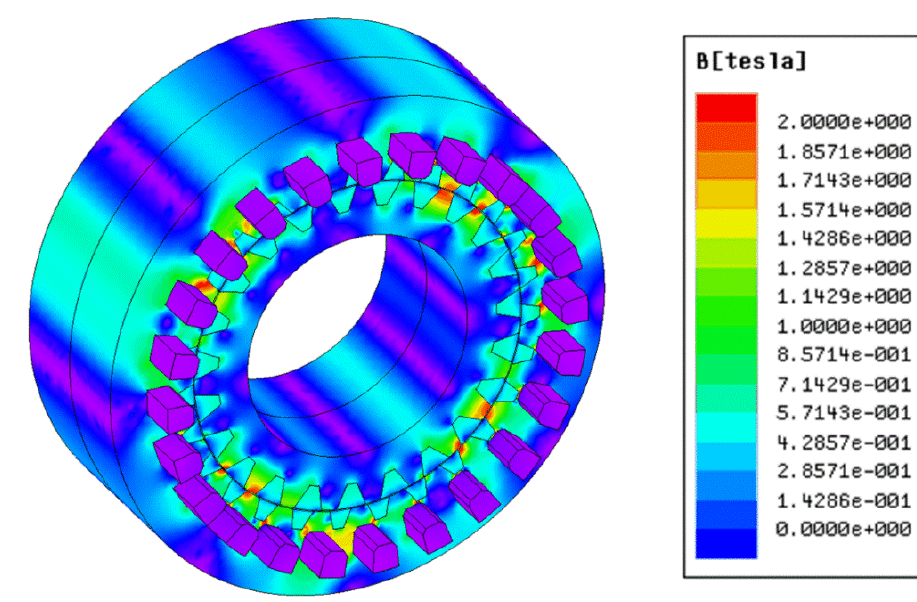
Figure 8. Three-dimensional (3D) flux density distribution in optimum case.